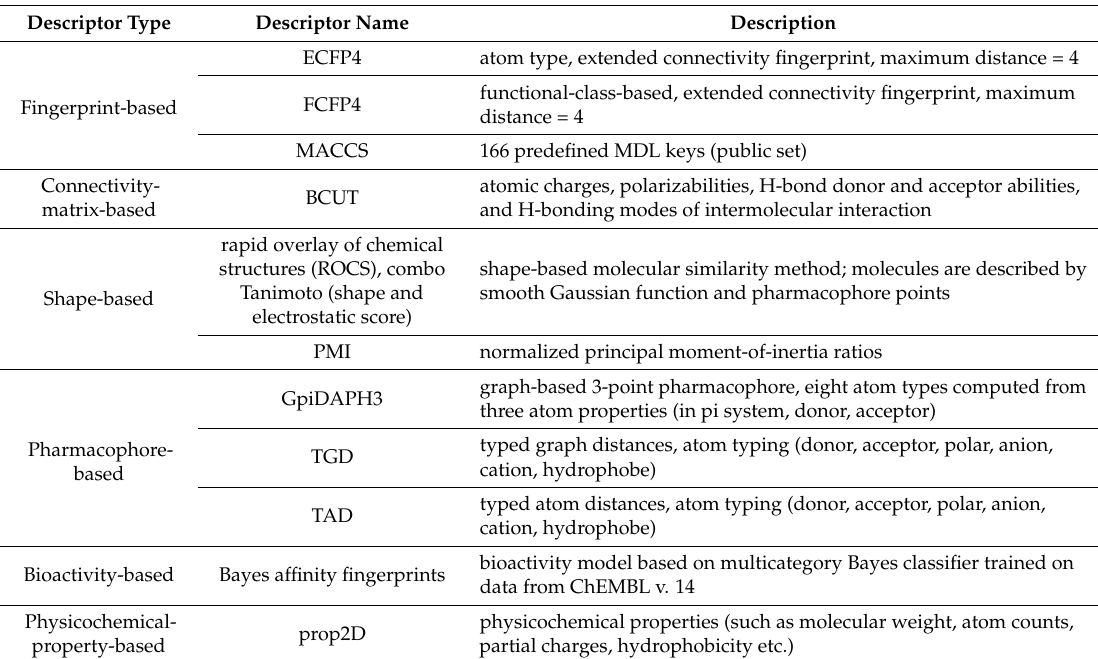
Table 1. The main types of traditional chemical descriptors